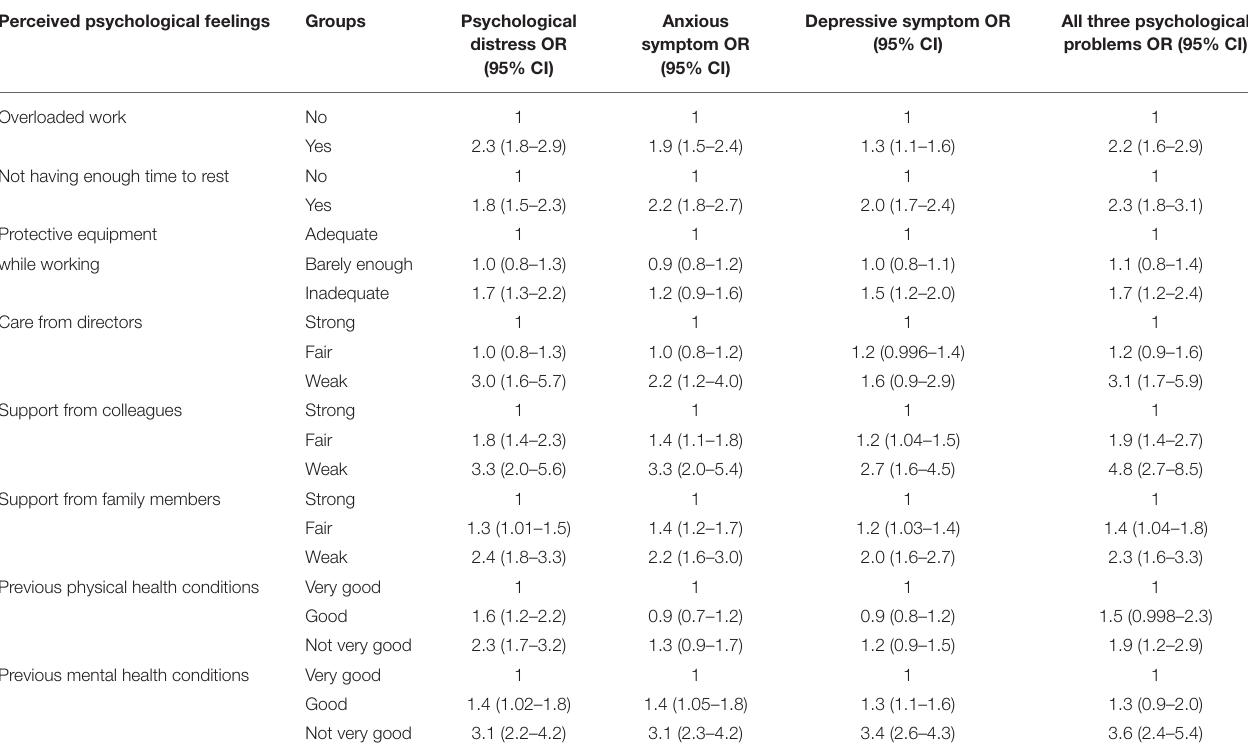
Anxious Depressive symptom OR All three psychological distress OR symptom OR (95% CI) problems OR (95% CI) (95% CI) (95% CI)